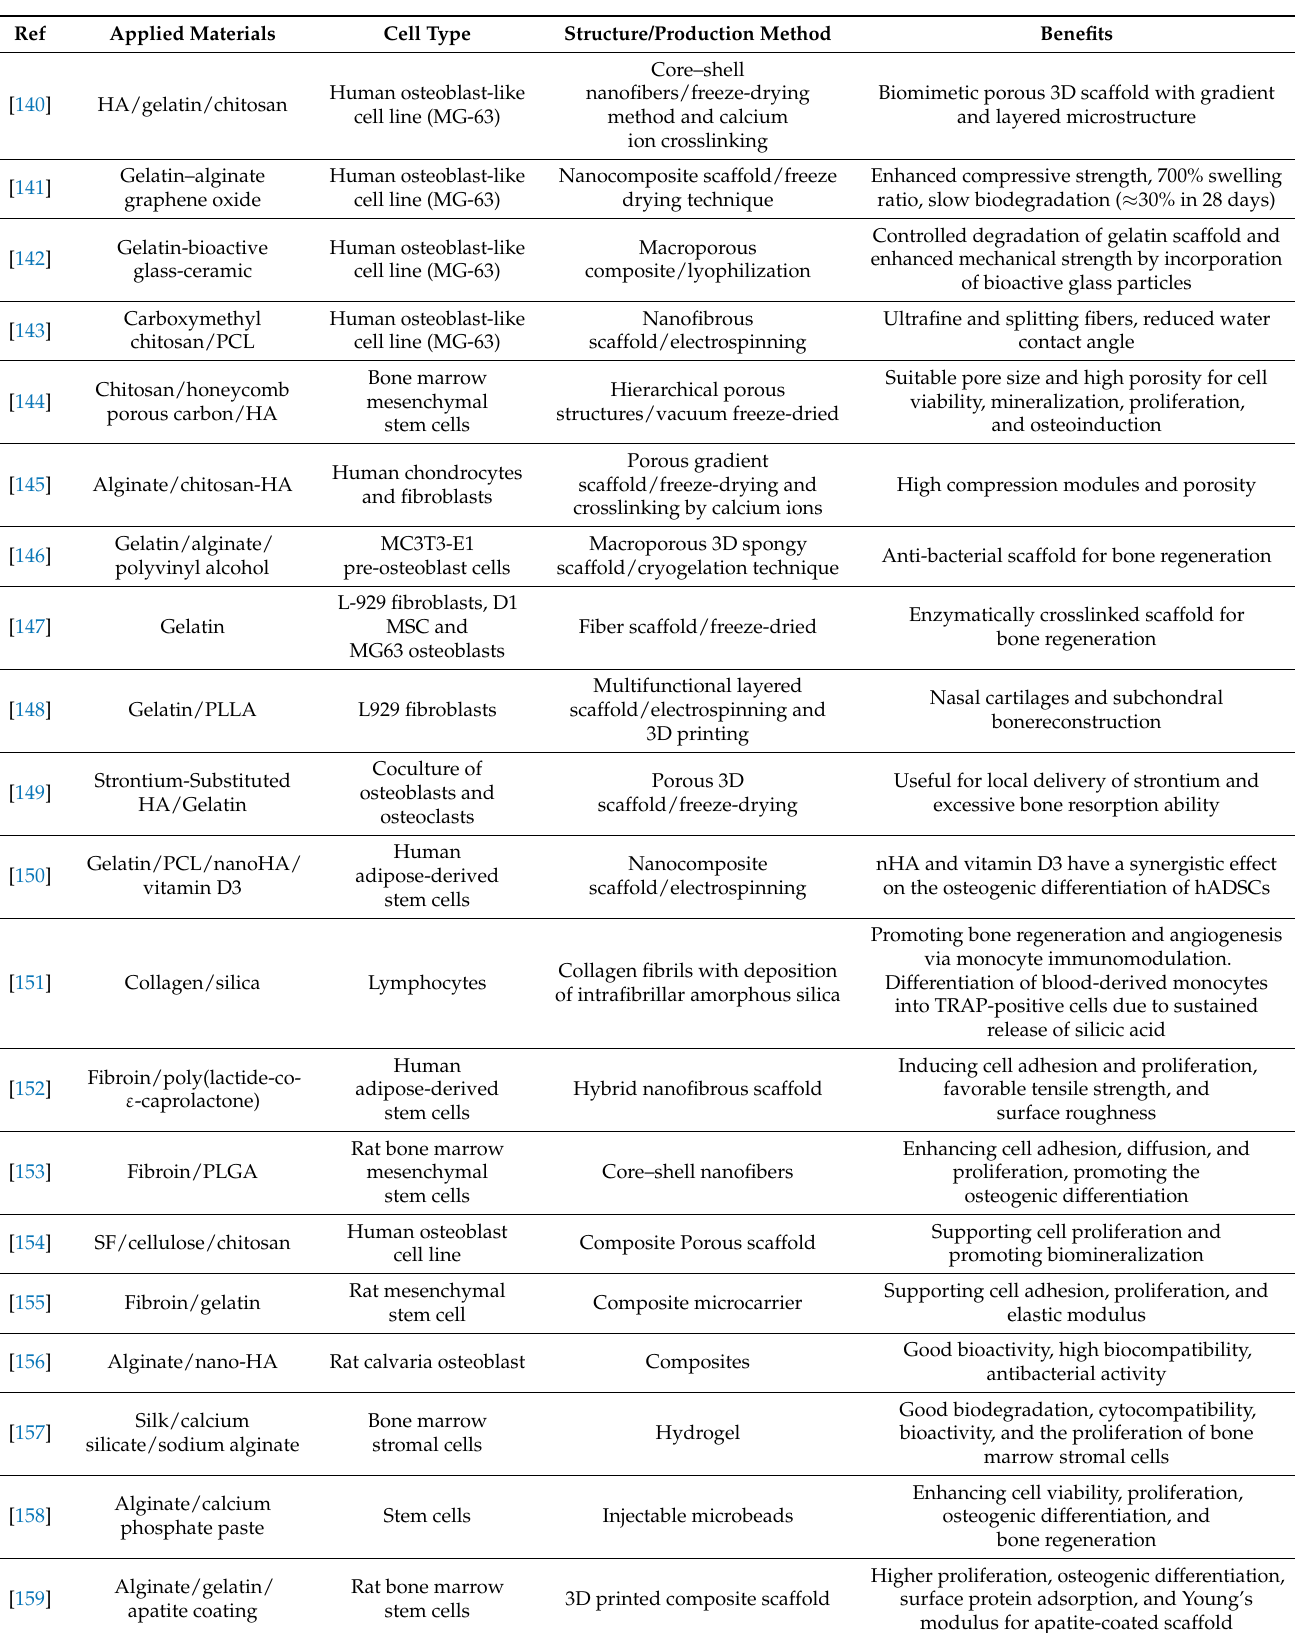
Table 2. Summary of recent studies using natural polymers in bone tissue